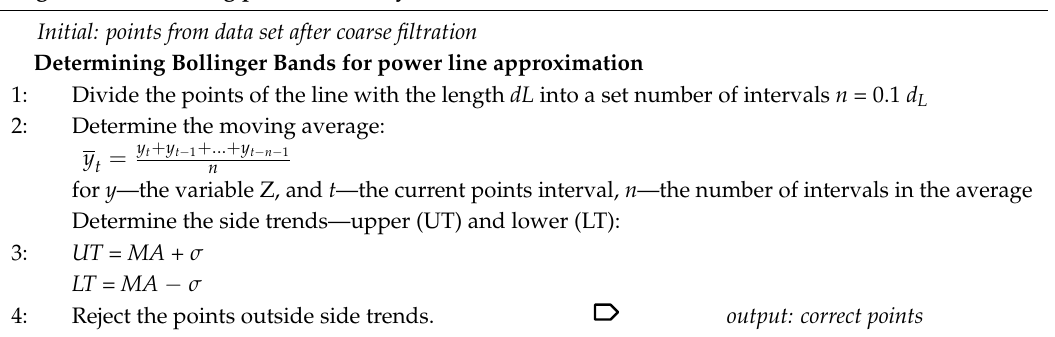
Algorithm 1. Filtering points horizontally Algorithm 2. Filtering points vertically